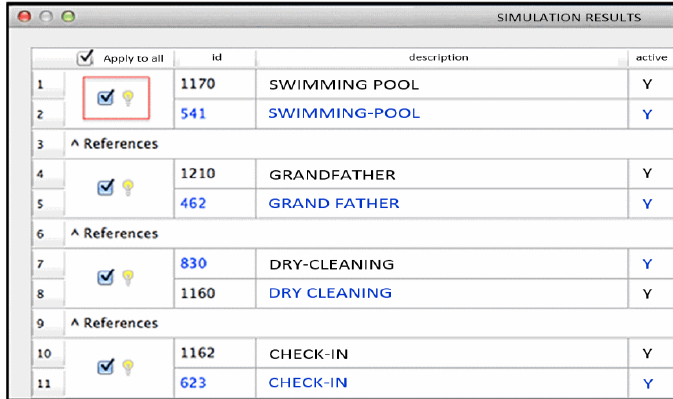
Figure 4: Training for cases of